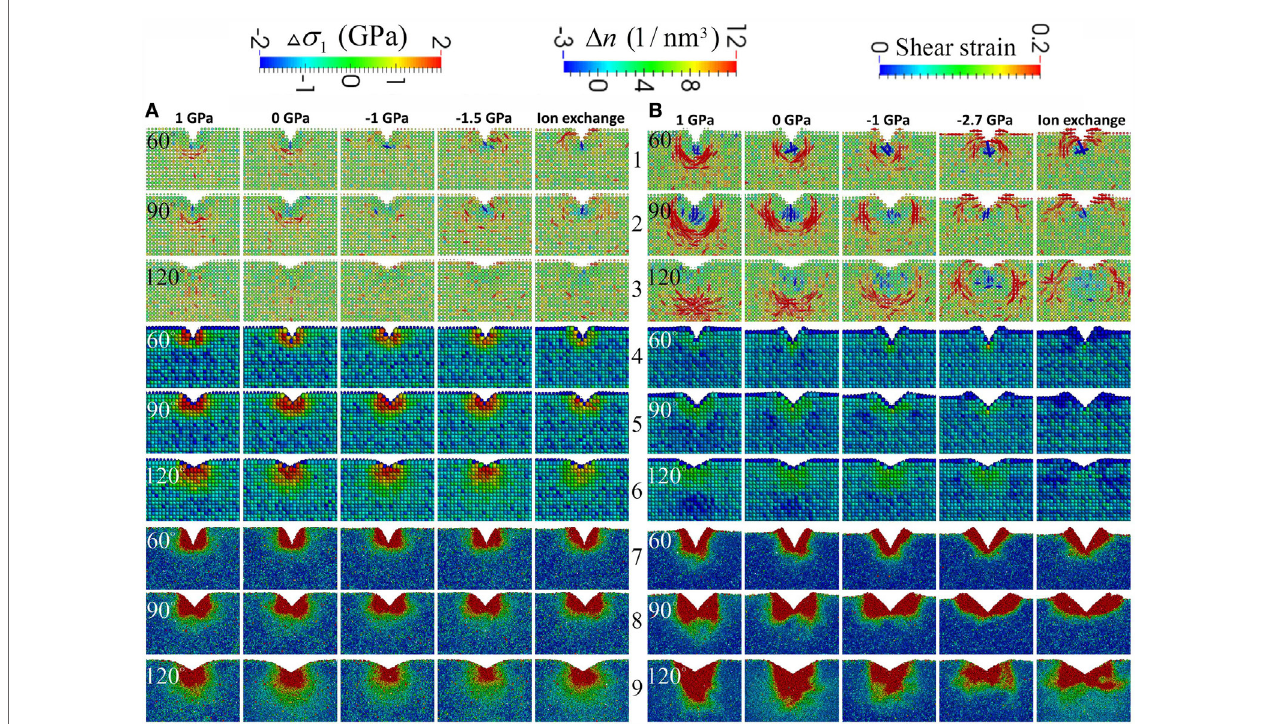
FigUre 5 | close-up view of the net first principal stress field after unloading in rows 1–3, the local number density change in rows 4–6, and the local shear strain in rows 7–9 for the base glass with high free volume in (a) and low free volume in (B) . The net stress field is defined as the current stress field subtracted by the initial stress field. The apparent voxel size is rendered proportional to the number of atoms it contains in order to better depict the profile of the surface of the sample. From left to right in (a,B) , each column corresponds to a different initial σ xx as labeled on the top. The last two columns in (a,B) have the same initial σ xx , which is achieved via mechanical and ion exchange methods, respectively. From left to right, the free volume effectively decreases in (a,B) . From top to bottom, every three rows correspond to the indenter angle of 60°, 90°, and 120°, respectively. The net residual stress field correlates strongly with the dilation zone in blue, especially for the sample with low free volume. The plastic zone shape indicated by the local shear strain changes dramatically for the sample with low free volume content, when CS is increased or the sample is ion exchanged. Note the correlation between the net residual stress field with the corners of the plastic zone in red, especially for the sample with low free volume